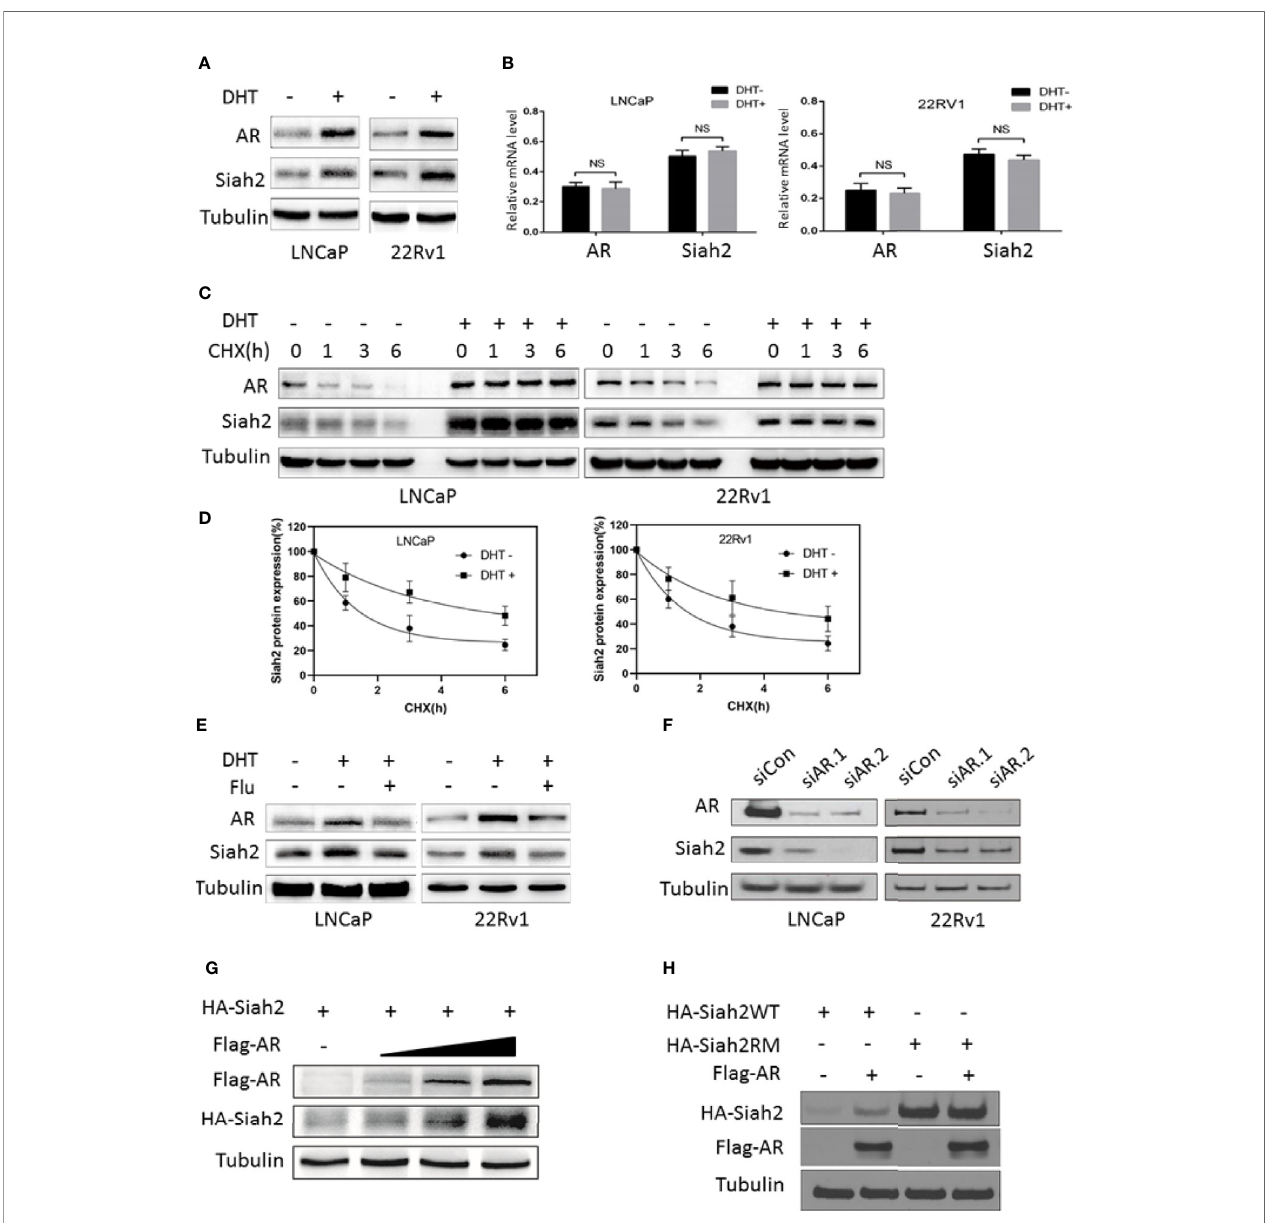
FIGURE 1 | Androgens stabilized Siah2 protein levels. (A) LNCaP and 22Rv1 cells were cultured in CS-FBS medium for 24 h, and then treated with 10 nM DHT or vehicle for 24 h. AR and Siah2 protein expression were detected using Western blotting. (B) LNCaP and 22Rv1 cells were treated as described in A, and then AR and Siah2 mRNA expression were detected by qPCR. (C) LNCaP and 22Rv1 cells were treated as described in A, and then treated with cycloheximide (CHX, 50 m g/ml) for 1, 3, and 6 h, after which cell lysates were subjected to Western blotting. (D) Degradation curves of Siah2 by cycloheximide chase experiments in the presence or absence of DHT. (E) LNCaP and 22Rv1 cells were treated as described in A, and then treated with fl utamide (5 m M) for 24 h. AR and Siah2 protein expression were detected using Western blotting. (F) LNCaP and 22Rv1 cells were transfected with two different siRNAs targeting Siah2 or control for 72 h,